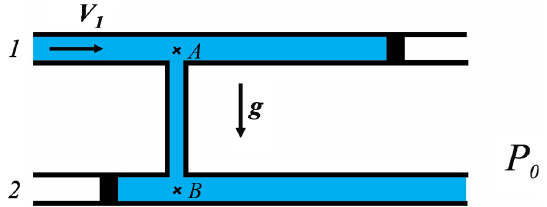
FIG. 6. Open container with constant level h discharging through a vertical pipe of length L